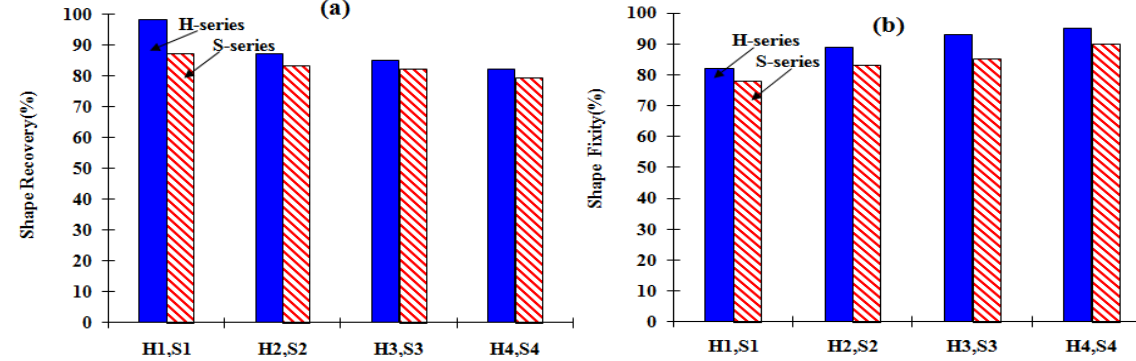
Figure 9. Shape recovery and shape fixity of the PEG ( a ) and PCL SMPUs ( b ) at 60 °C and 50%